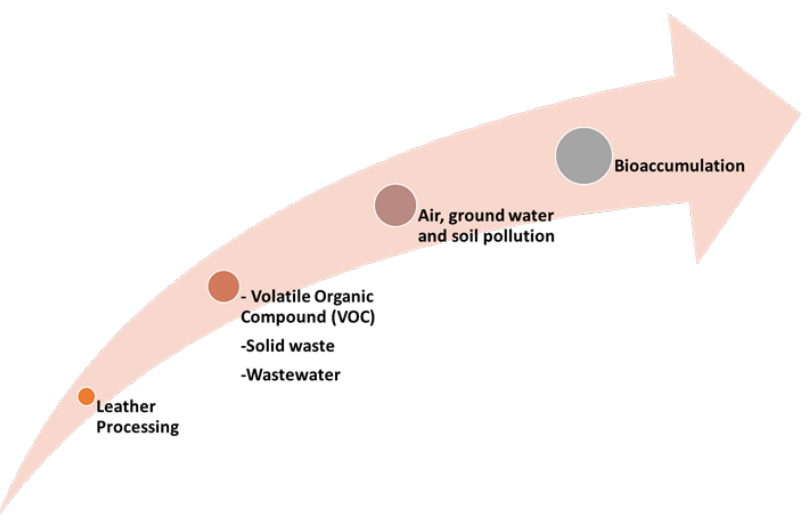
Scheme 2. Environmental pollution of the leather industry. Table 3. Physical characteristic and composition of chrome-tanned leather shavings (CTLSs).